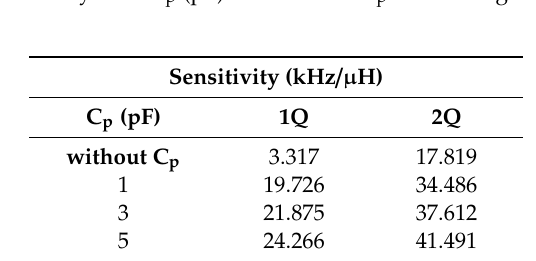
Table 1. Converter’s sensitivity with C p (pF) and without C p for the single- and dual-quartz crystal units in parallel.